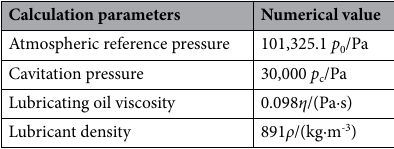
Table 1. Parameters for the numerical experiments.